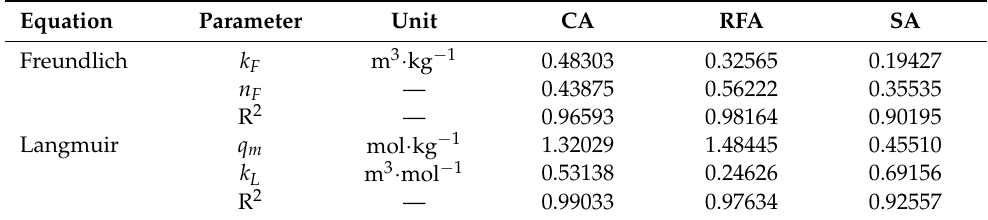
Table 10. Adsorption isotherm parameters for CuDI6 from scCO 2 solution at 10.6 MPa and 308 K on different substrates [61].